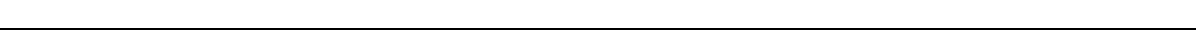
Fig. 7 A single QNZ-46 pre-treatment produces high levels of white matter and gray matter neuro-protection. a – c Brain lesion volume 24 h post-tMCAO. d – f Functional recovery prior to the killing. Drug treatment signi fi cantly improved the outcome in all measures. ANOVA with Holm − Š ídák post test. P values: b ***0.0000; c **0.000; e **0.004; f *0.011. Mann − Whitney test; d *<0.05. g – j YFP expression (green) and luxol fast-blue/cresyl violet (blue/ purple: myelin) in Thy-1-YFP mice. g YFP( + ) axons project within the external capsule which is extensively myelinated in contralateral (Contra) and ipsilateral (Ipsi) hemispheres in sham-operated mice. Higher power micrographs are shown at the bottom. h Mice treated with vehicle show disruption and loss of axonal YFP that extends to both hemispheres and loss of myelin within the ipsilateral white matter. i Drug-treated mice retain YFP( + ) axons and myelin staining in both hemispheres. j Myelin stain density is signi fi cantly reduced in the vehicle-treated group (***0.0002), and preserved by QNZ-46 pre-treatment (**0.005). Scale bars = 100 μ